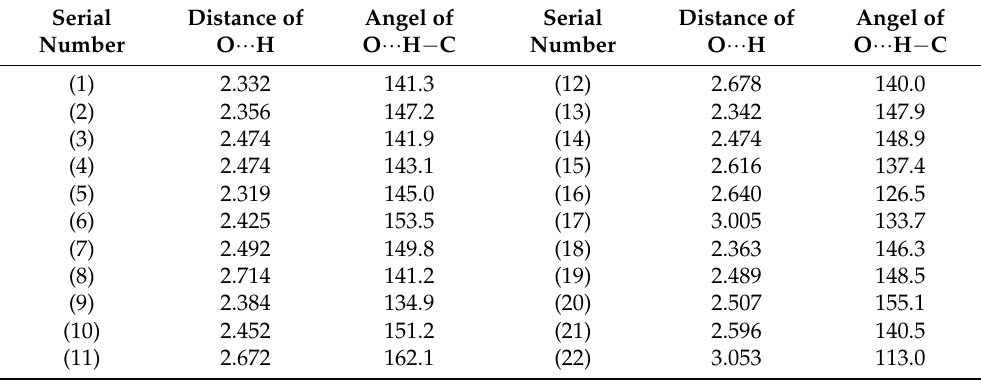
Figure 3. Optimized geometries of the transition state TS2/3 in hydride addition to CO 2 . Pink balls: Ru; orange: P; red: O; blue: N; cyan: C; white: H; The distances are in Å, and the O − C − O bond angles are in degree ( ◦ ). The red dotted lines represent hydrogen bonds, and the number indicates the distance of O ··· H (Å). The detailed parameters of these hydrogen bonds are listed in Table 4. Table 4. Parameters of hydrogen bonding in the optimized geometries of the transition state TS2/3 during hydride addition to CO 2